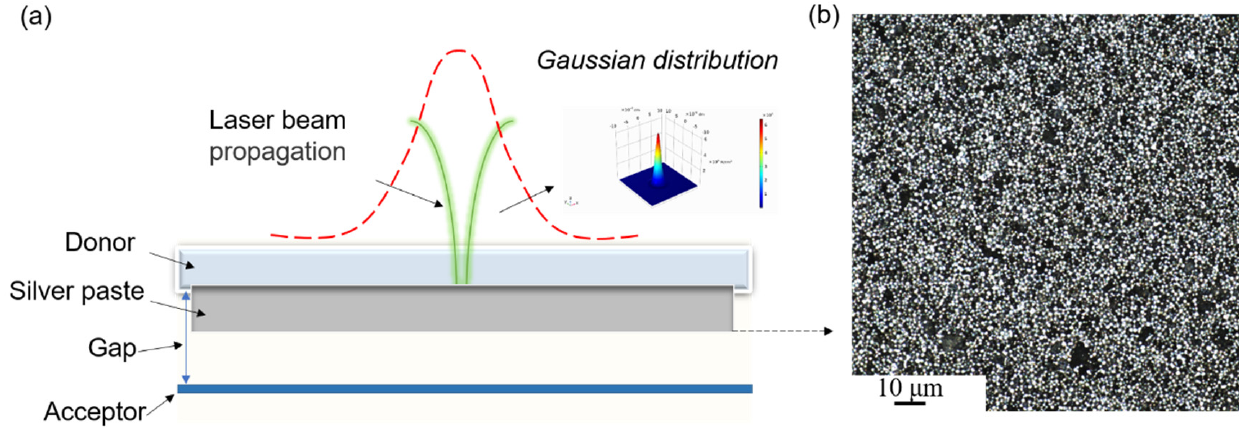
Figure 1. ( a ) schematic diagram of laser-induced forward transfer, ( b ) silver paste coated on the donor.